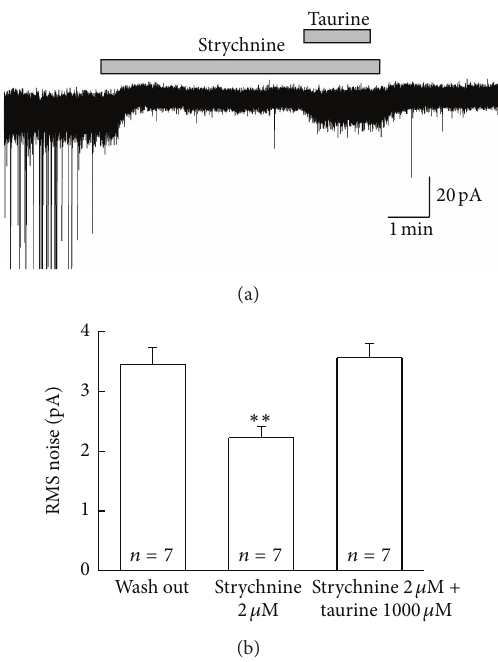
Figure 8: Taurine-mediated tonic conductance via extrasynaptic glycine and GABA receptors on SG neurons. (a) The representative trace illustrated that strychnine 2 𝜇 M mediated an outward shift of holding current by blocking glycine-mediated neurotransmission andblockedthetaurine-inducedsynapticcurrentsexceptGABA mediated extrasynaptic current. (b) The bar graph showing the comparison of RMS noise in intact condition, in the presence of strychnine 2 𝜇 M and in the spontaneous application of taurine 1,000 𝜇 M and strychnine 2 𝜇 M ( ∗∗ 𝑃 < 0.01 ). Holding potential was −